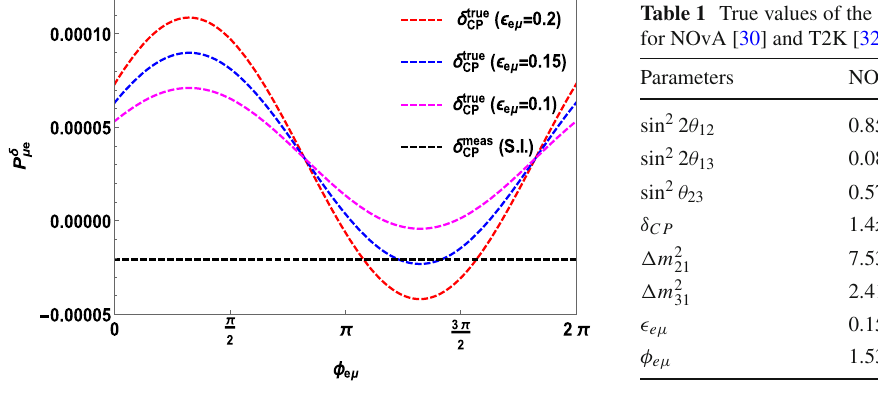
magenta curve ( ε e μ = 0 . 1) and the black curve (SI) indicat- ters for this value of ε e μ . On the other hand, when ε e μ = 0 . 15 (blue), ε e μ = 0 . 2(red),wecanclearlyseeanoverlapbetween